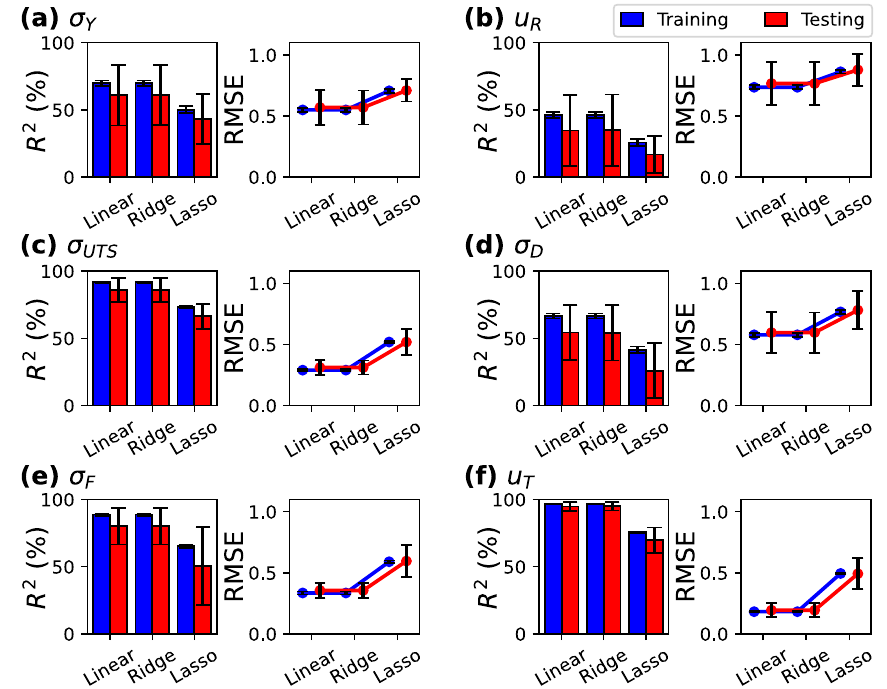
2 Figure 5. Coefficient of correlation ( R ) and RMSE for the plastic properties ( a ) σ Y , ( b ) u R , ( c ) σ UTS , ( d ) σ D , ( e ) σ F , and ( f ) u T . RMSE curves were horizontally–displaced for visualization